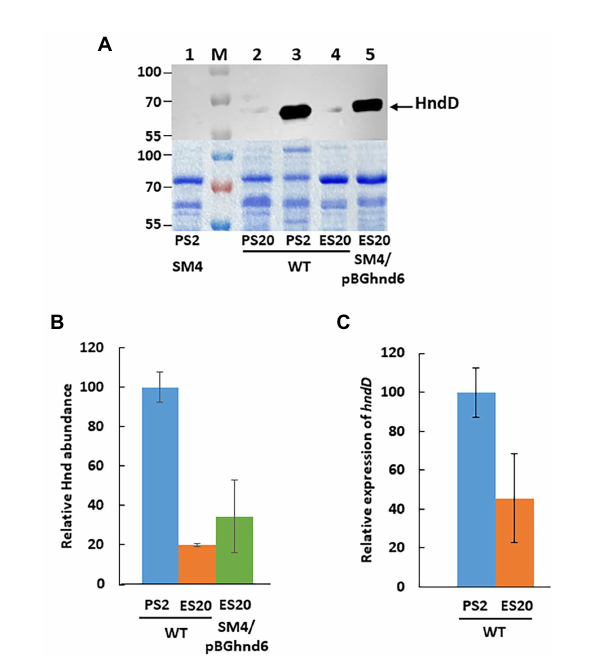
FIGURE 3 Hnd level in S. fructosivorans under pyruvate and ethanol conditions. (A) Western blot analysis of HndD production by WT (lanes 2–4), SM4 (lane 1) and SM4/pBGhnd6 (lane 5) cells of S. fructosivorans grown with pyruvate (PS2, lanes 1 and 3, or PS20, lane 2) or ethanol (ES20, lanes 4 and 5) as carbon source. Cells were harvested at stationary phase of growth and 15 μ g of total proteins from soluble extracts were separated by 10% SDS-PAGE and subjected to western blotting using an antibody raised against HndD. Molecular mass markers (lane M) are indicated in kDa. The SDS-PAGE below the western blot is a loading control. (B) Relative Hnd level determined by quantitative proteomics. S. fructosivorans WT and SM4/pBGhnd6 strains were grown with pyruvate (PS2) or ethanol (ES20) as carbon source and cells were collected at stationary phase of growth. Data represent the averages of the results of three experiments. Error bars correspond to standard deviations. (C) Relative expression of the hndD (DesfrDRAFT_0401) gene quantified by RT-qPCR. S. fructosivorans WT strain was grown with pyruvate (PS2) or ethanol (ES20) as carbon source and samples were collected at stationary phase of growth. Expression of the gene was normalized to that of the 16S rRNA gene. Data represent the averages of the results of three experiments. Error bars correspond to standard deviations.